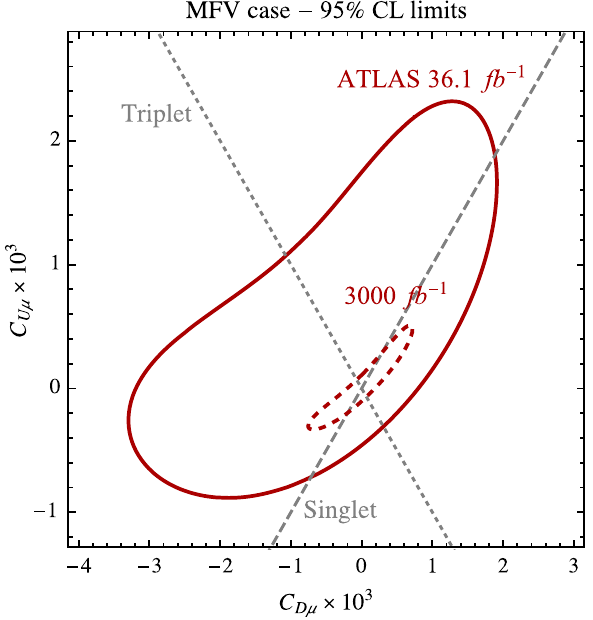
Fig. 3 Present and projected 95% CL limits from pp → μ + μ − in the MFV case defined by Eq. (14)